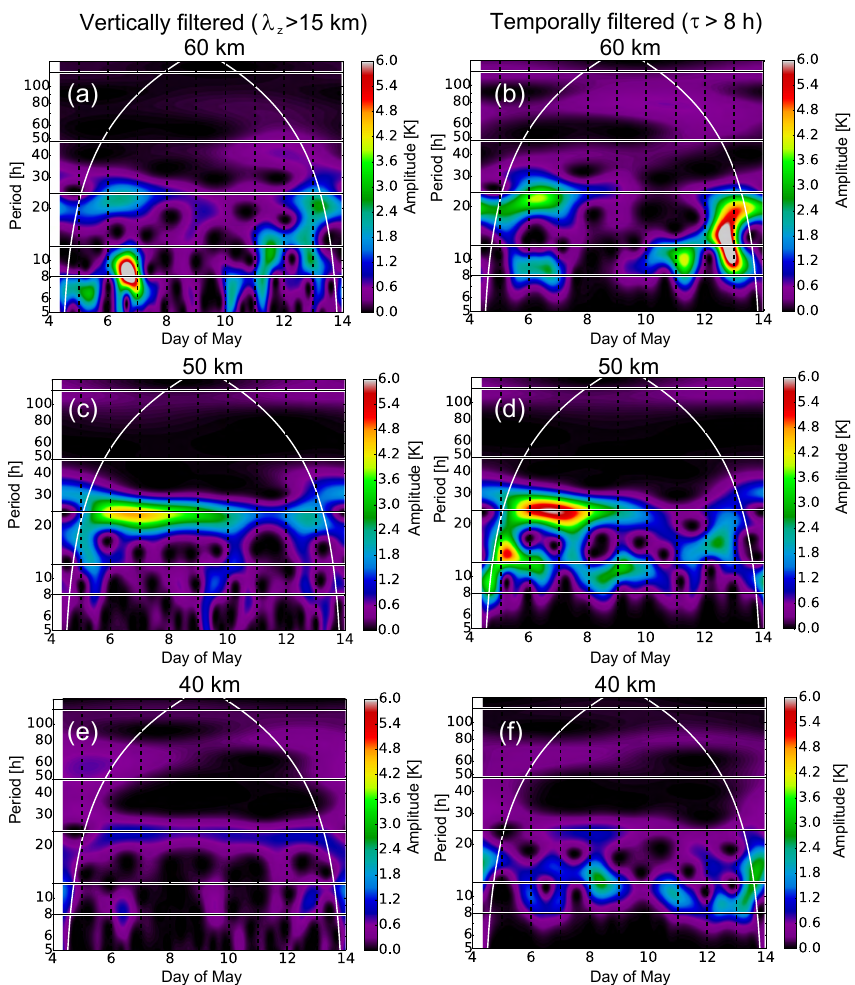
Figure 4. Wavelet spectra for periods of large-scale waves calculated from vertically (a, c, e) and temporally filtered data (b, d, f) on 4– 13 May 2016 at an altitude of 40km (e, f) , 50km (c, d) , and 60km (a, b) . The horizontal lines indicate periods with 8, 12, 24, 48, and 120h. The curved white line shows the edge of the cone of influence.